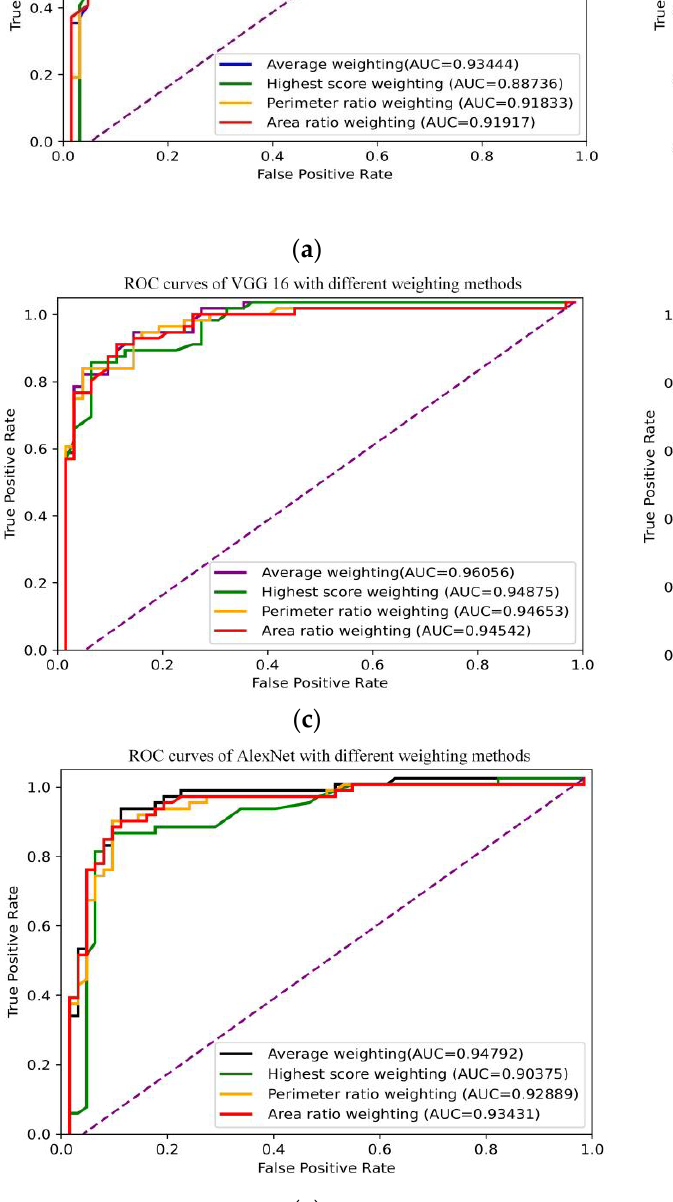
Figure 5. Lesion-level receiver operating characteristic (ROC) curves and (area under curve) AUC value of DCNNs with different weighting methods and SSBS ROI. ( a ) ResNet50. ( b ) DenseNet. ( c ) VGG16. ( d ) GoogLeNet. ( e ) AlexNet.